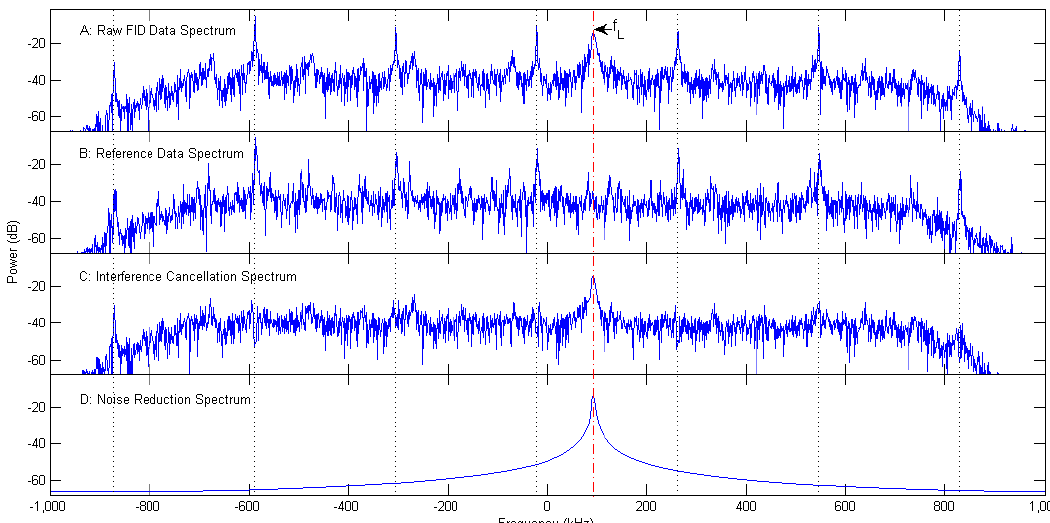
Figure 7. The effect of interference cancellation and noise suppression. The spectra of ( A ) the raw FID data; ( B ) the reference data; ( C ) the FID data after interference cancellation with a threshold value of 0.5; ( D ) noise suppression by preserving only the largest one of the remaining singular values.